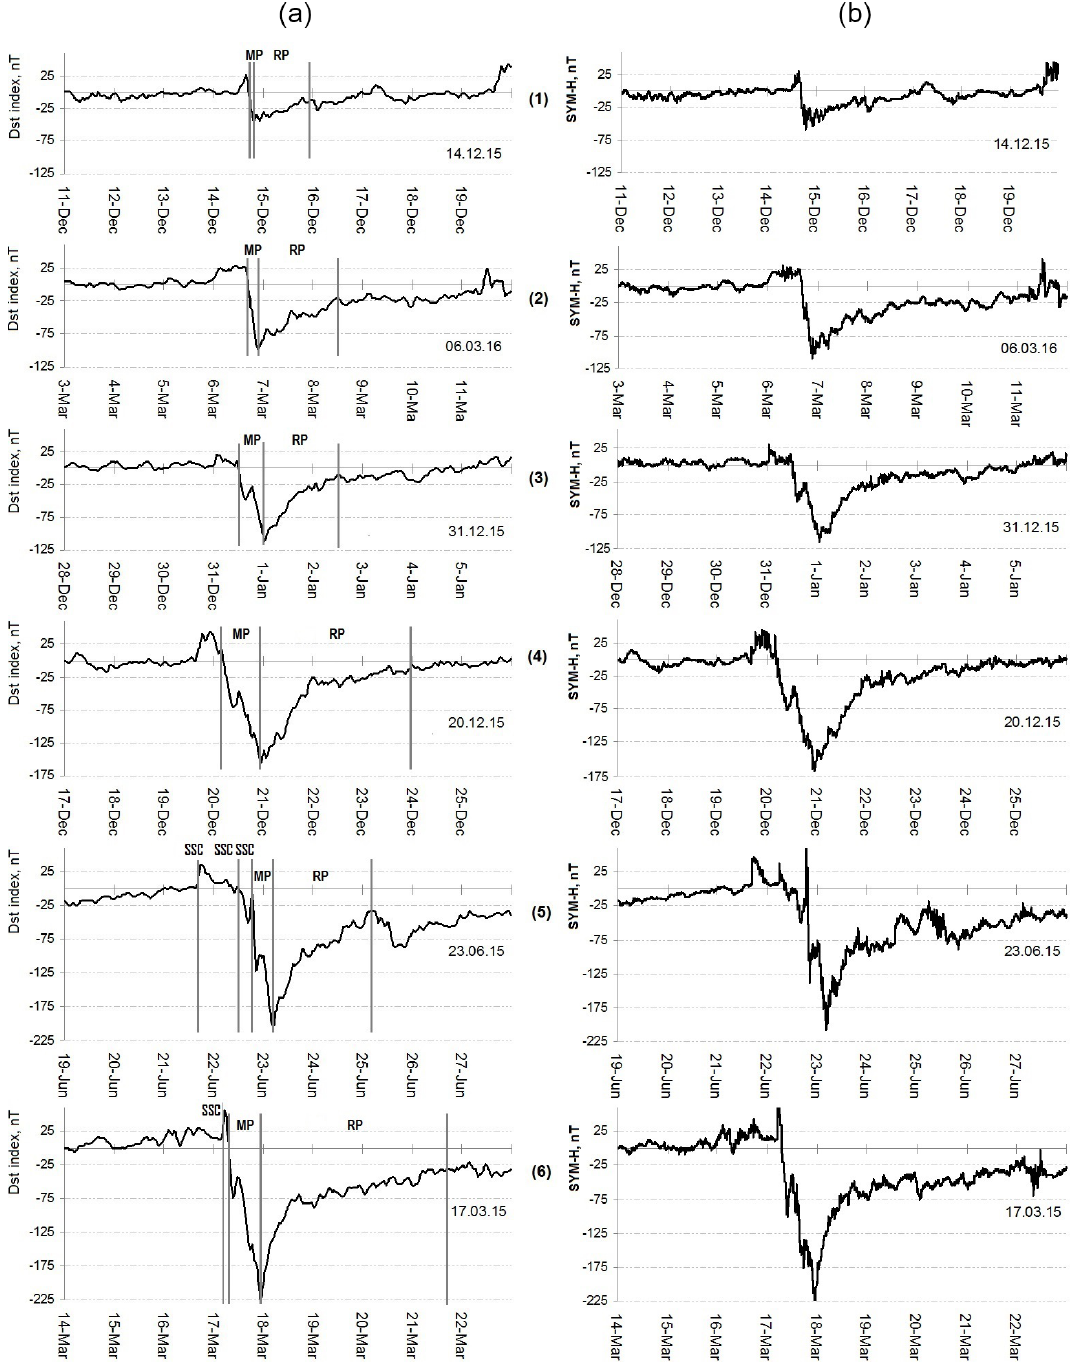
Figure 1. Dst index (a) and SYM-H index (b) variations during the periods of six geomagnetic storms under analysis. Main (MP) and recovery phases (RP) as well as sudden storm commencements (SSCs) are marked by vertical lines based on Dst index